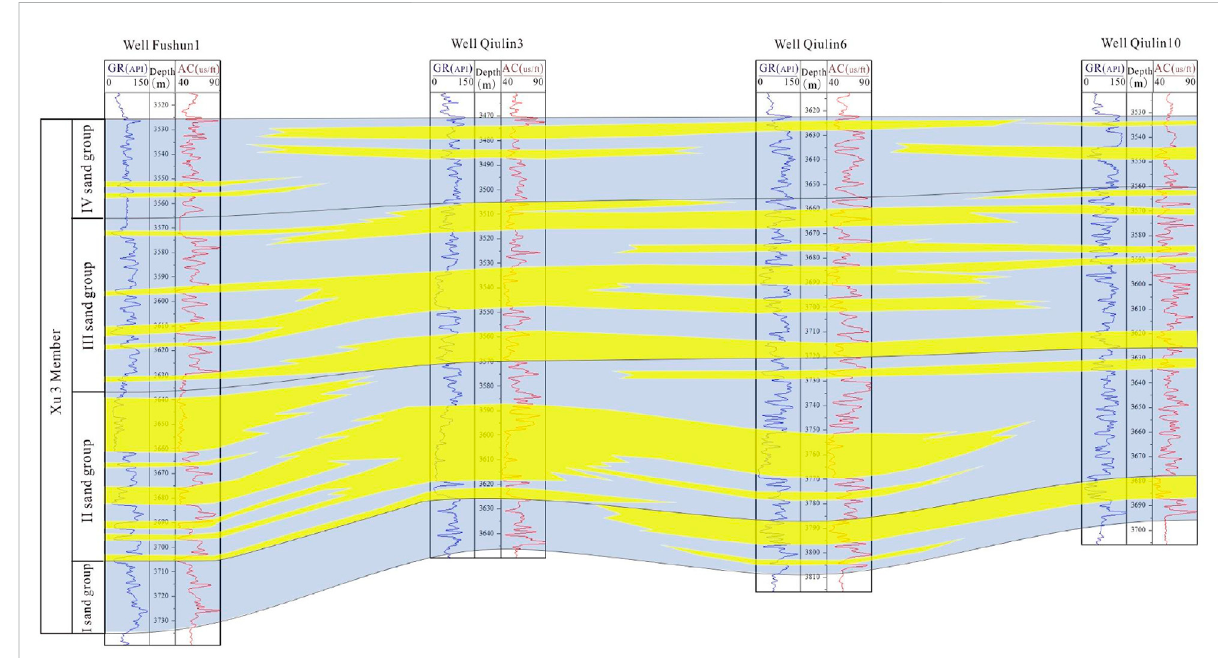
FIGURE 5 Well-connected pro fi le of the source-reservoir assemblage within the source of the Xu 3 Member (the plane position is shown in Figure 8). Yellow represents sandstone and grey represents